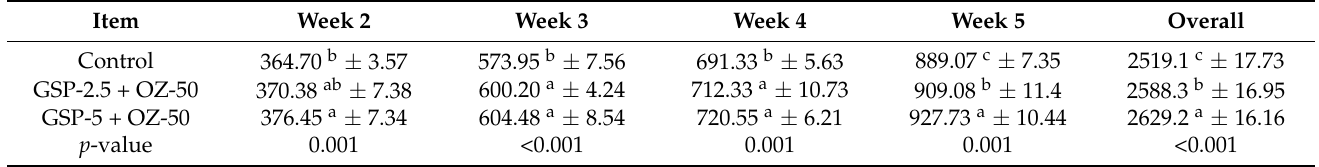
Means within the same column with different superscripts are statistically different ( p < 0.05). GSP-2.5 + OZ-50: grape seed powder and zinc–glycine chelate at the rates of 2.5 g/kg and 50 mg/kg, respectively; GSP-5 + OZ-50: grape seed powder and zinc–glycine chelate at the rates of 5 g/kg and 50 mg/kg,